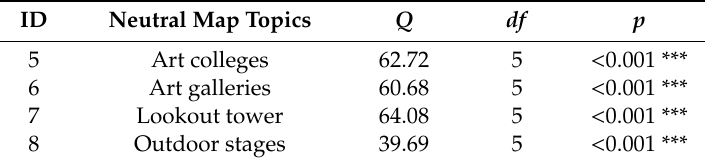
Table 4. Results of the Durbin-Skillings-Mack test for neutral map topics.